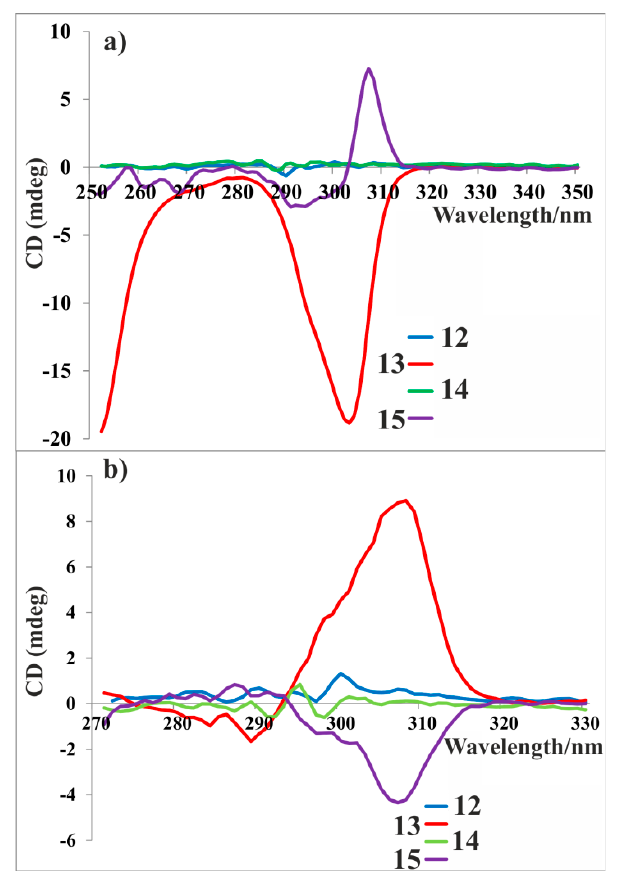
Figure 2. Circular dichroism spectra of pillar[5]arenes 12 – 15 at 1 × 10 − 4 M: ( a ) in water; ( b ) in DMSO.